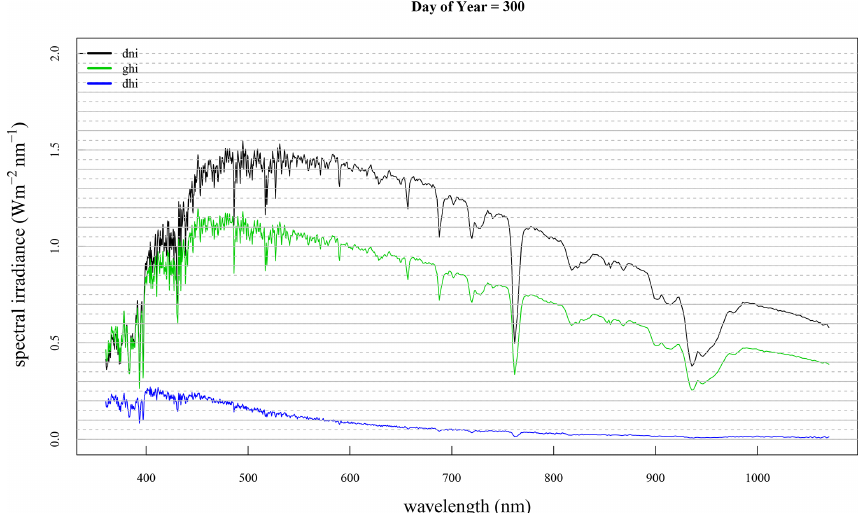
Figure 11. Spectral irradiance calculated using RSS measurements for three solar components near solar noon at the ARM site in northern Oklahoma on 27 October